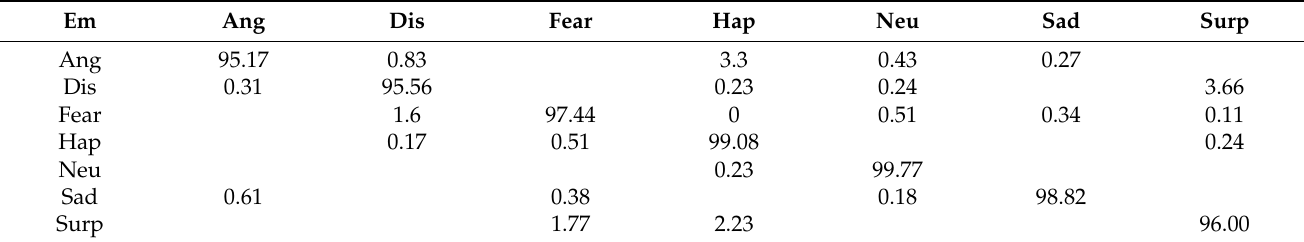
Table 4. Matrix representing the confusions in MUG dataset.